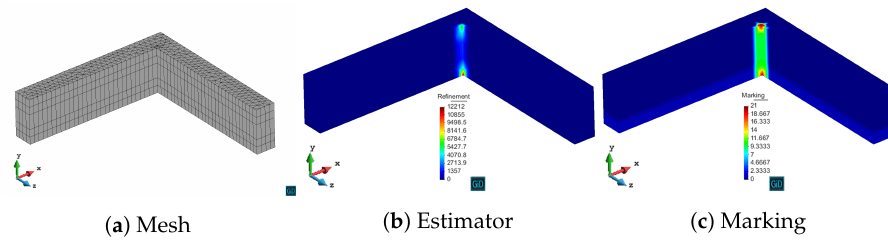
Figure 19. Second iteration for L-shaped problem with h adaptivity.